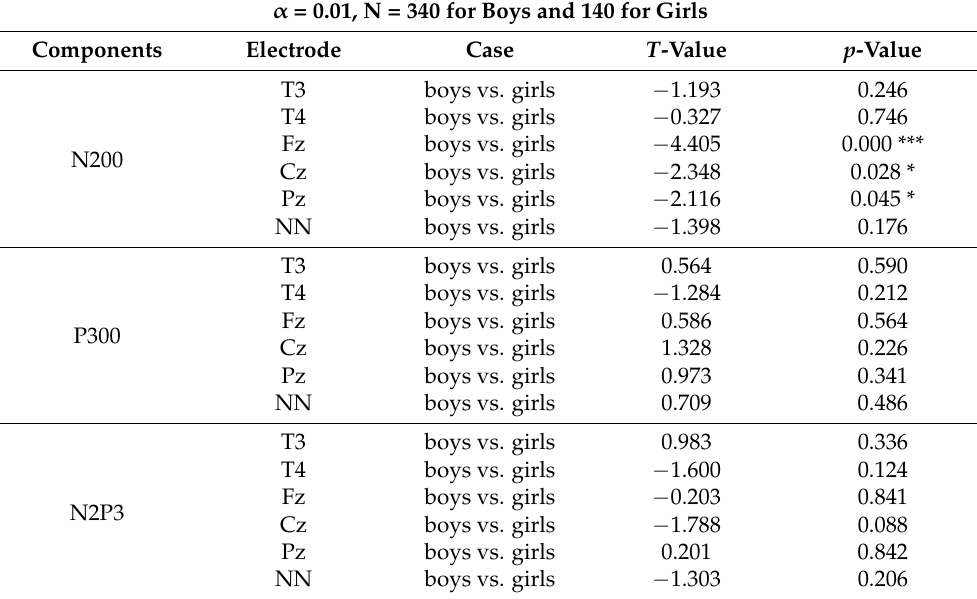
Table 12. Independent samples t-test results of all trials between girls and boys. α = 0.01, N = 340 for Boys and 140 for Girls Components